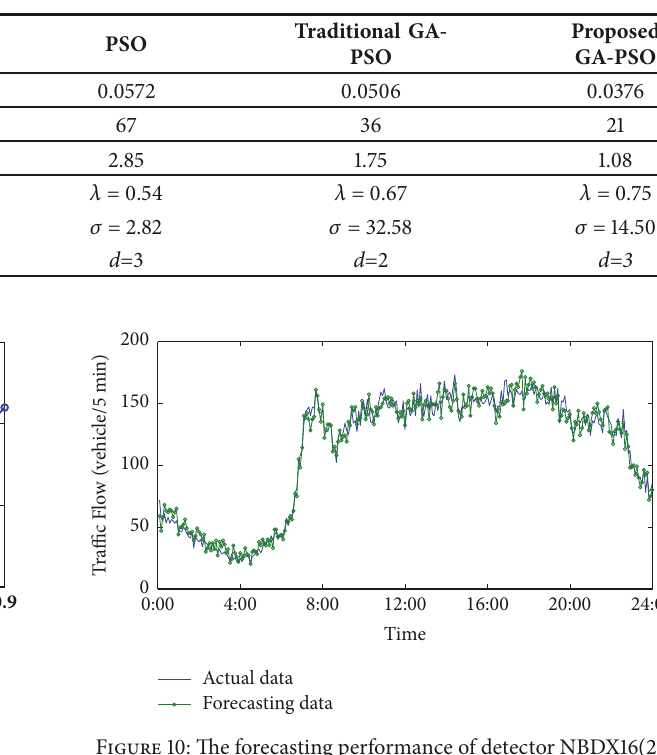
Table 3: Comparison results of different algorithms.